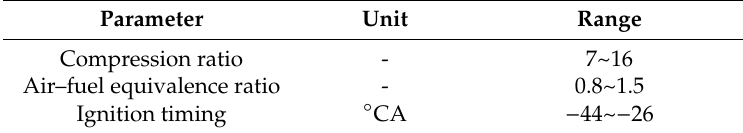
Table 8. Parametric settings for the knocking performance analysis of the Engine A.